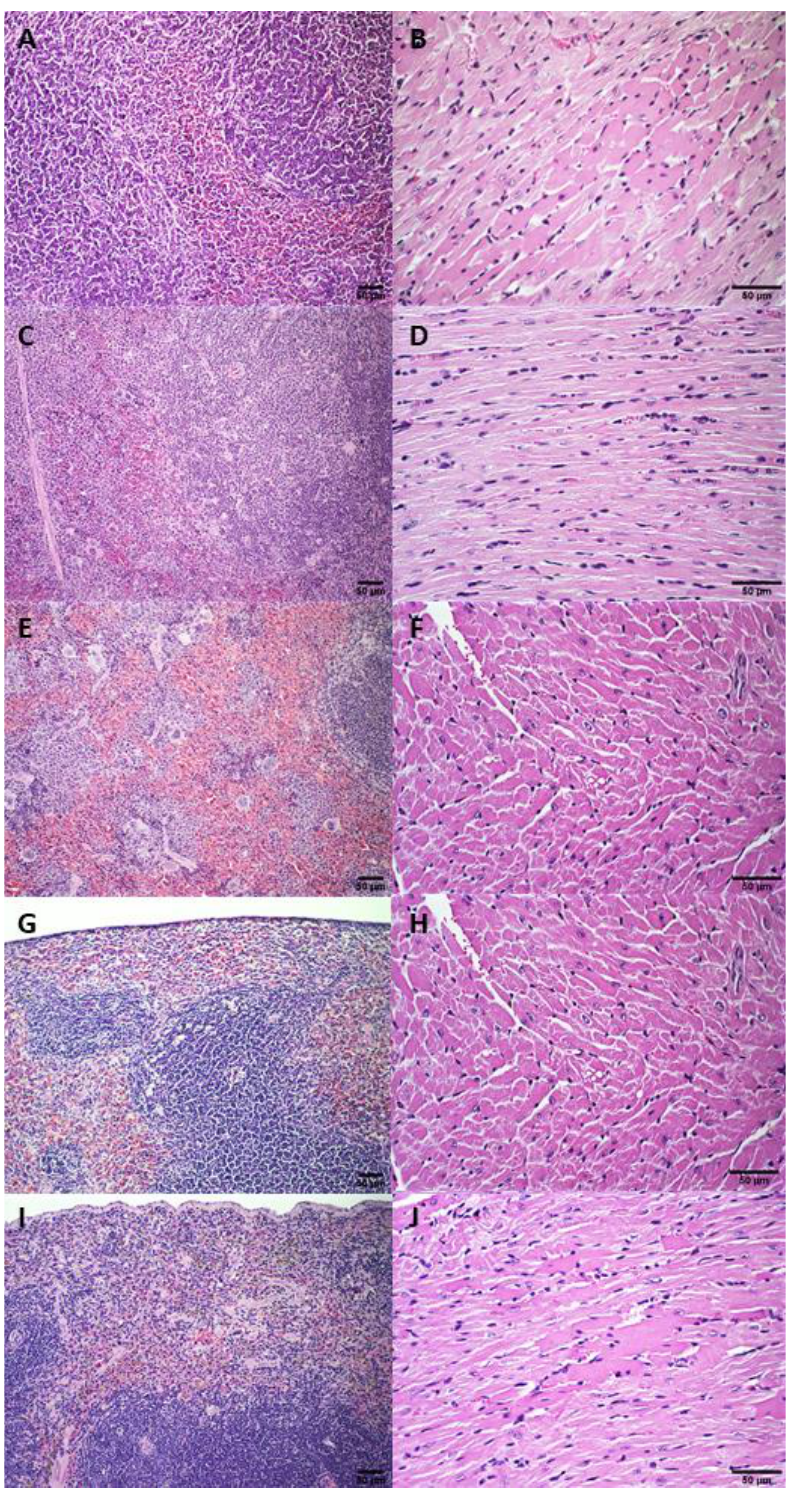
Figure A9. Histological sections of the spleen and heart of female Balb/c mice bearing 4T1 breast tumors treated with HBS ( A , B ), ExoSpHL ( C , D ), and DOX at a cumulative dose of 25 mg/kg ( E , F ), SpHL-DOX at a cumulative dose of 25 mg/kg ( G , H ), and ExoSpHL-DOX at a cumulative dose of 25 mg/kg ( I , J ).